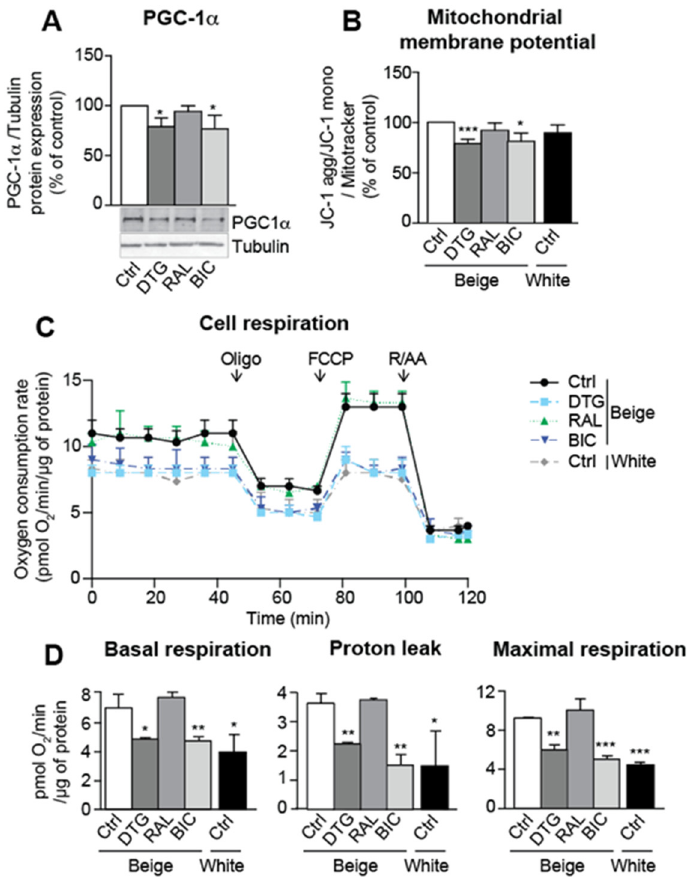
Figure 4. Treatment with an INSTI during beige adipocyte differentiation is associated with impaired mitochondria function and respiration. ASCs were differentiated into adipocytes as described in Figure 2. ( A ) Whole-cell lysates were prepared and analyzed using immunoblots. Repre- sentative immunoblots of PPAR γ -coactivator-1 α (PGC-1 α ) and tubulin are shown. Densitometry analyses ( n = 6) against tubulin as loading control were performed and expressed as a mean % of the value for control cells ± SEM ( n = 6). ( B ) The cationic dye, JC-1, was used to evaluate the mito- chondrial membrane potential. The fluorescence results normalized against the mitochondrial mass (evaluated using MitoTracker Red dye) are expressed as the mean ± SEM % JC-1 aggregate/mono- mer ratio, relative to control cells ( n = 9, in duplicate). ( C ) The oxygen consumption rate (OCR) of cells treated sequentially with oligomycin (Oligo), carbonyl-cyanide-p-trifluoromethoxyphenyl-hy- drazon (FCCP), or rotenone and antimycin A (R/AA). OCR were normalized against the protein content and expressed as the mean ± SEM ( n = 3, in quadruplicate). ( D ) Basal respiration, proton leakage, and maximal respiration were calculated, as described in Material and Methods. * p < 0.05, ** p < 0.01, *** p < 0.001 vs. control cells. 3.5. Dolutegravir Enhances the Expression of Profibrotic Genes in Beige Adipocytes In line with our in vivo data, dolutegravir increased the expression of collagens (COL1A2, COL6A1 and COL1A1) (Figure 5A–B), lysyl-oxidase (LOX, a crucial enzyme